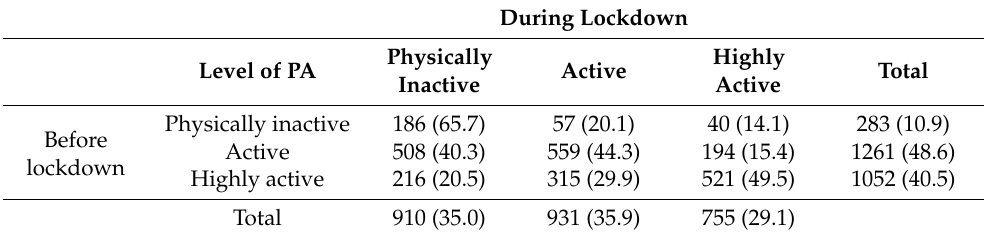
Table 2. Comparison of categorical IPAQ scores before and during the